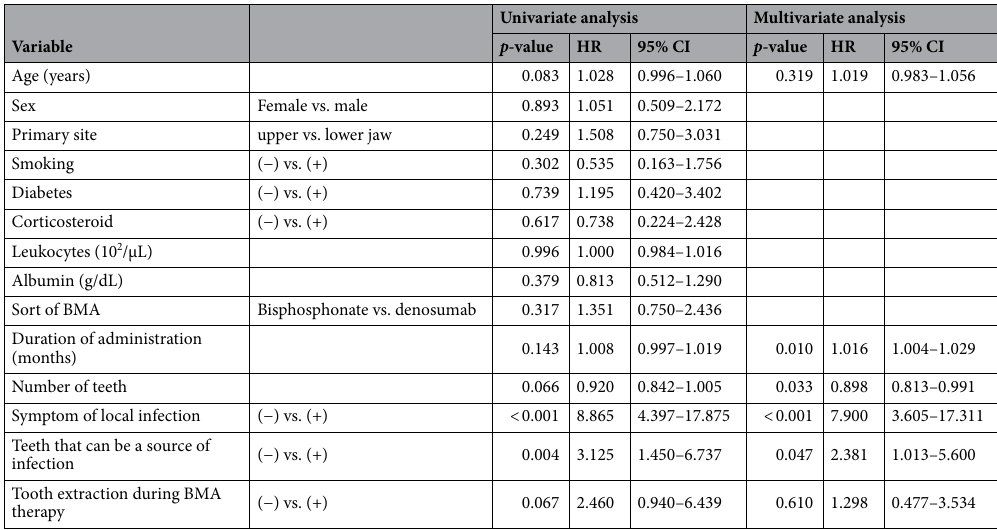
Table 2. Relationship between each variable and development of MRONJ (per jaw). *Cox regression analysis. Teeth that can be a source of infection: periapical lesion (> 3 mm) or aloveolar bone loss (> 1/2) or probing pocket depth (> 4